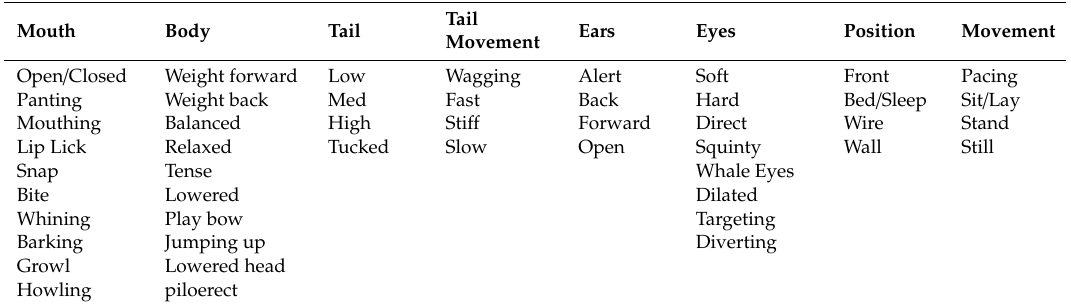
Table 1. Canine behaviours recorded for each body part, as well as positions and movement types.